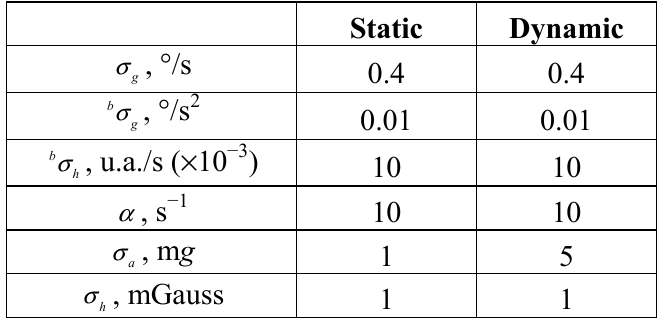
Table 2. The orientation sensor delivers the data from the magnetic sensor in arbitrary units. Table 2. EKF parameter setting (experimental